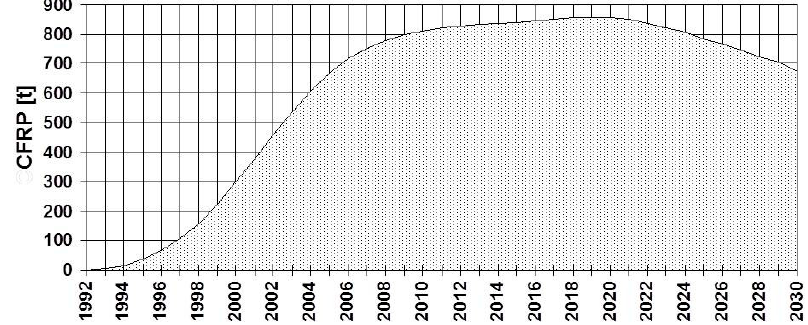
Figure 10. Taken from Meier [28]: Prediction of the worldwide demand of CFRP for external flexural post-strengthening in 1997. In 2014, the demand was in reality 7500 metric tons!